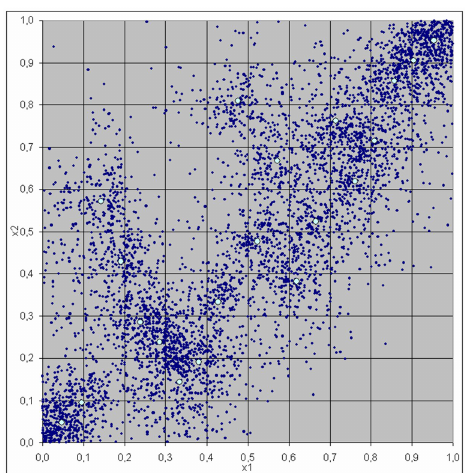
Figure 26: Power copula with rook copula driver, Figure 27: Power copula with rook copula